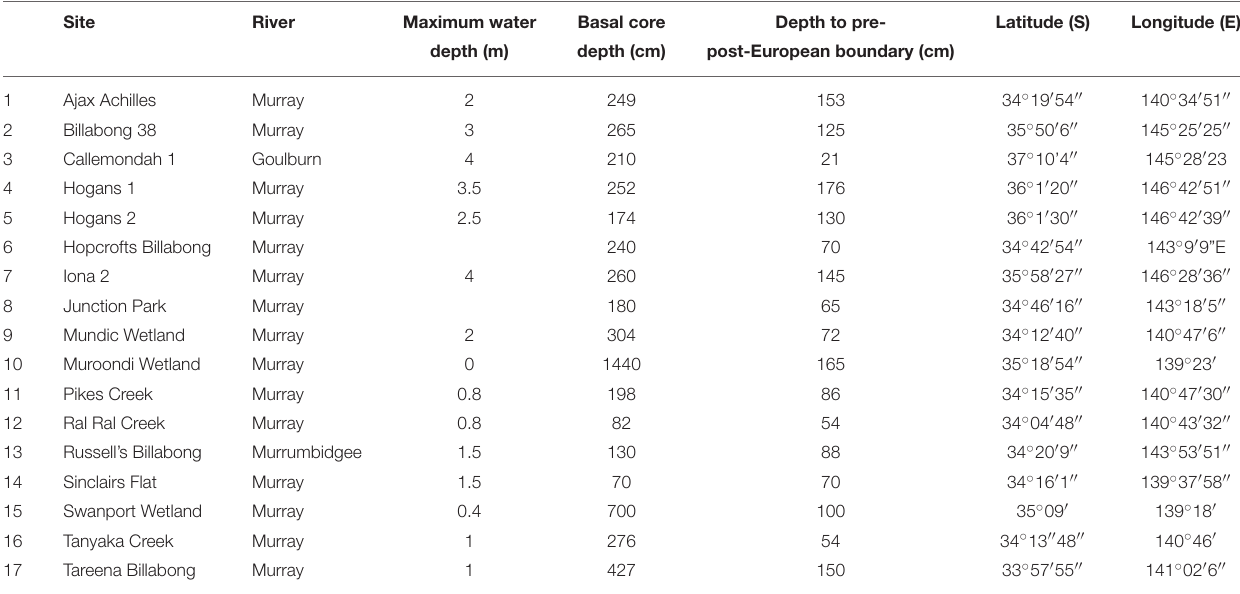
TABLE 1 | Features of the 17 wetlands